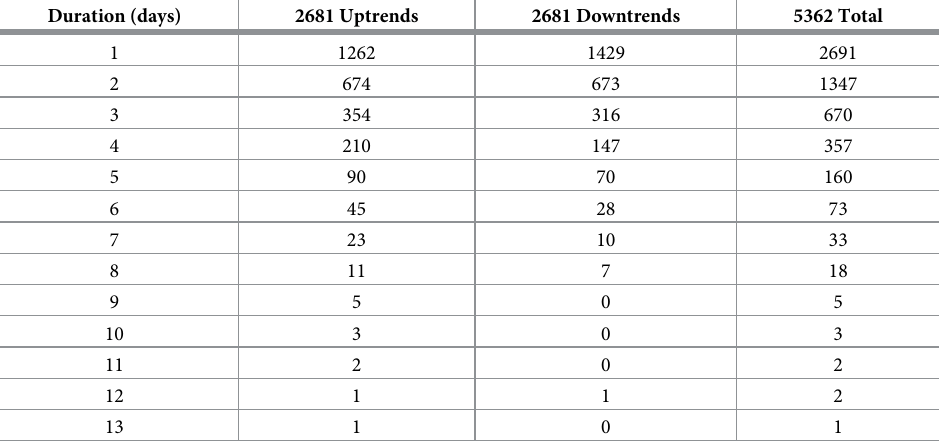
Table 2. Composition of uninterrupted trends observed in the DJIA data sample.